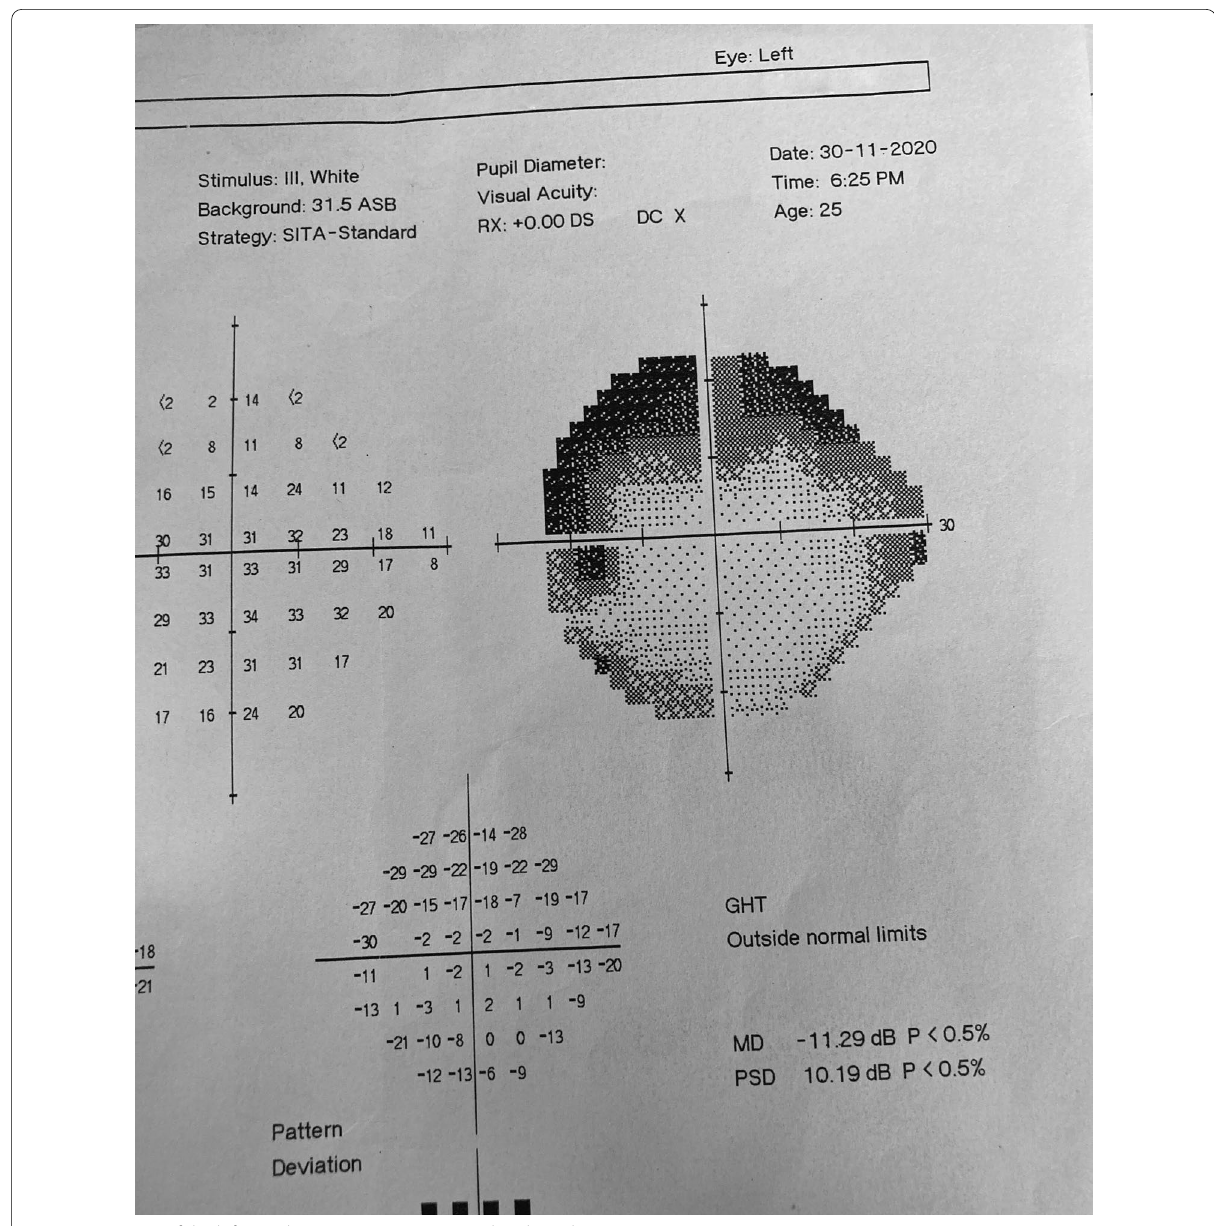
Fig. 8 Perimetry of the left eye showing superior temporal and nasal arcuate